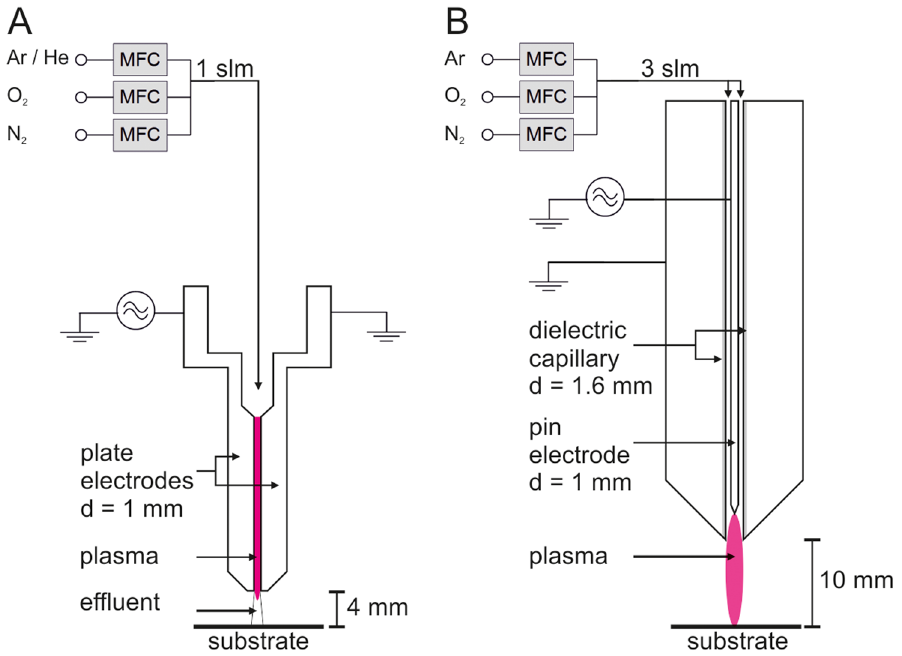
Figure 8. Schematics of the COST-jet ( A ) and kINPen ( B ). MFC: mass flow controller, slm: standard litre per